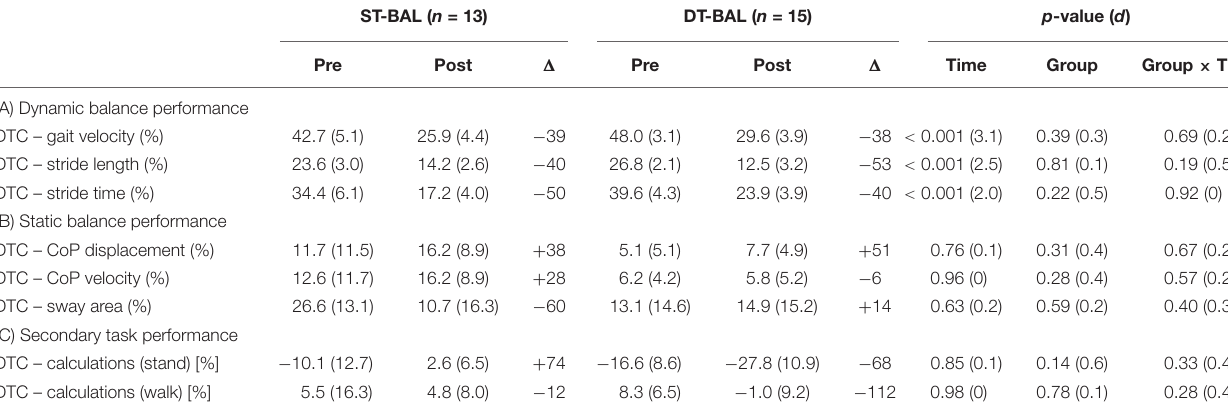
TABLE 3 | Outcome measures (ANOVA with repeated measures on Time). ST-BAL ( n = 13) DT-BAL ( n = 15)